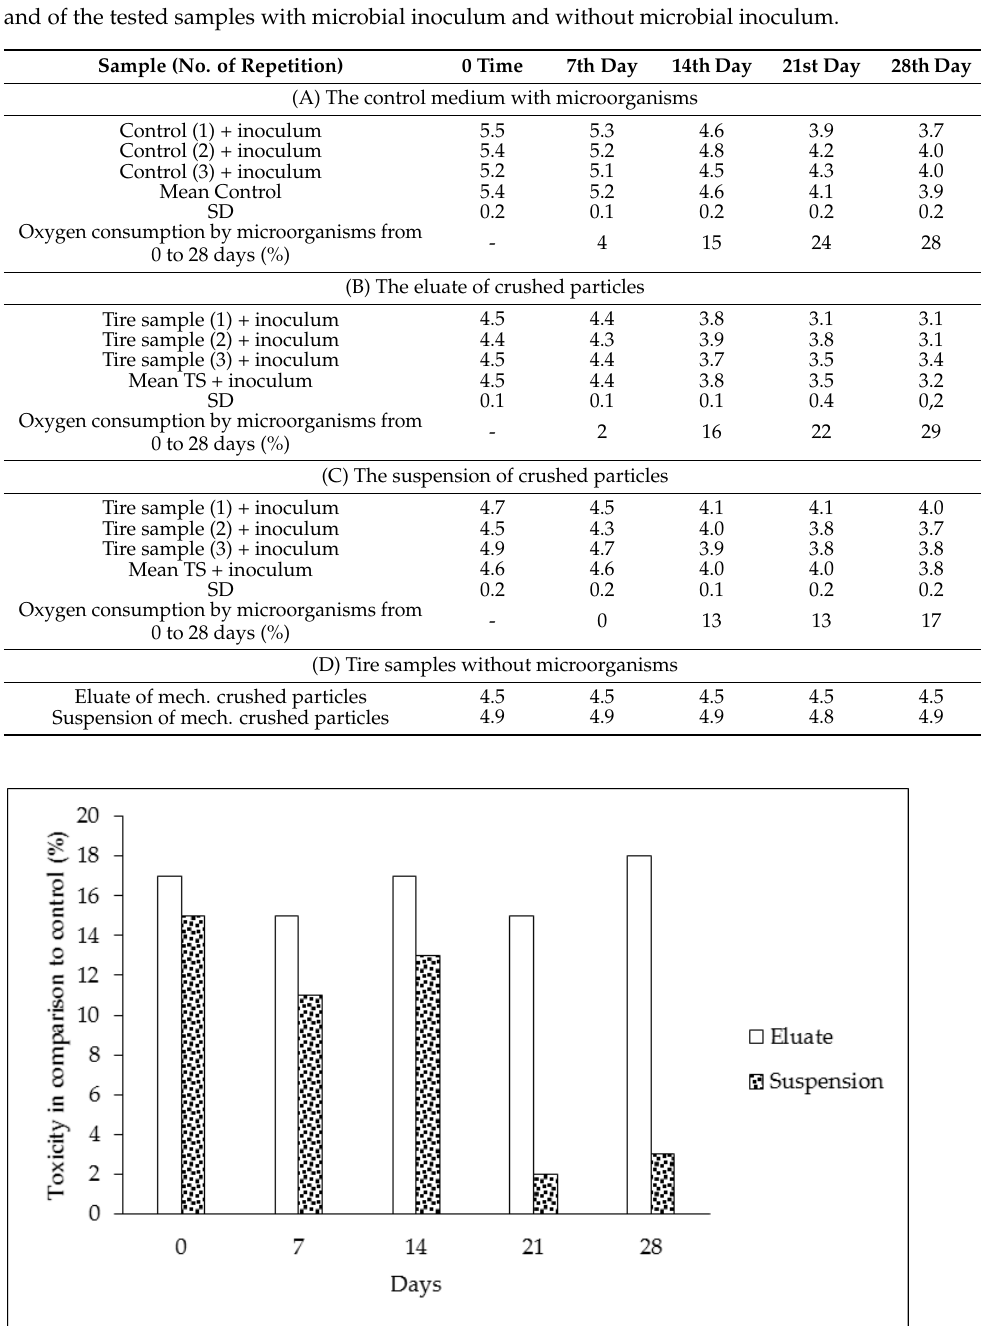
Figure 3. Toxicity of the samples in comparison to the controls during 28 days of the experiment—day 0, 7, 14, 21 and 28 (the data were calculated according to Formula (2)). The results of the MTT assay confirmed the results of the test with dissolved